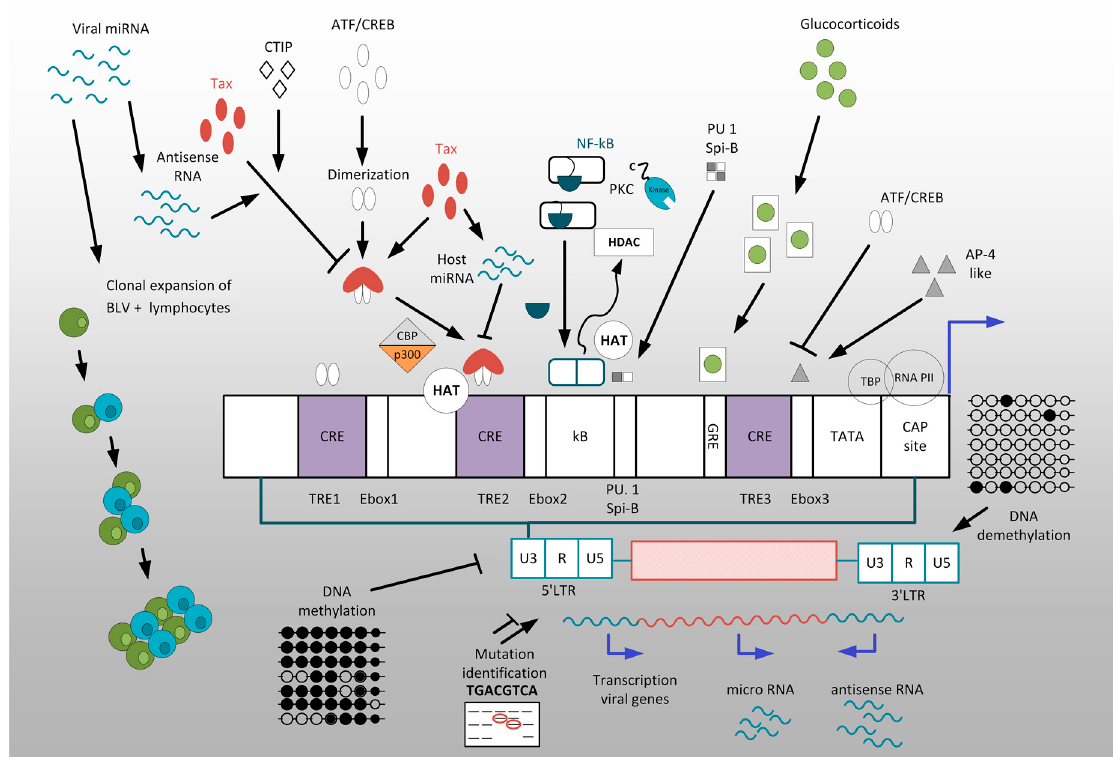
Figure 2. A schematic diagram of regulation of expression in BLV. The scheme illustrates the interactions that induce 5 ′ LTR transcription: TRE element and the Tax/ATF/CREB and CBP/p300 complexes; NF-kB, PKC, and HAT; glucocorticoid receptor (GR), glucocorticoids and glucocorticoid response element (GRE); demethylation within 3 ′ -LTR; some mutations within regulatory elements of the LTR; and the interaction that repress 5 ′ LTR transcription: antisense RNA and Tax; CTIP and Tax; NF-kB and HDAC; AP-4 like protein ATF/CREB and E box; methylation within 5 ′ -LTR; some mutations within the LTR. Black sharp arrows indicate an induction of 5 ′ LTR transcription, black blunt arrows indicate repression of 5 ′ LTR transcription. Clonal expansion of BLV + lymphocytes is another mode of viral propagation. Transactivation of transcription at the viral LTR is a critical role of Tax in BLV infected cells as this ultimately leads to the expression of all viral genes. The LTR is divided into the U3, R and U5 regions. The U3 region is of significant importance in Tax-mediated transcription and thus is highlighted in the expanded box. This region contains three TRE-1,2, 3 and CRE regions; Ebox1,2,3; κ B; PU.1/Spi-B region; GRE; TATA box and CAP site.